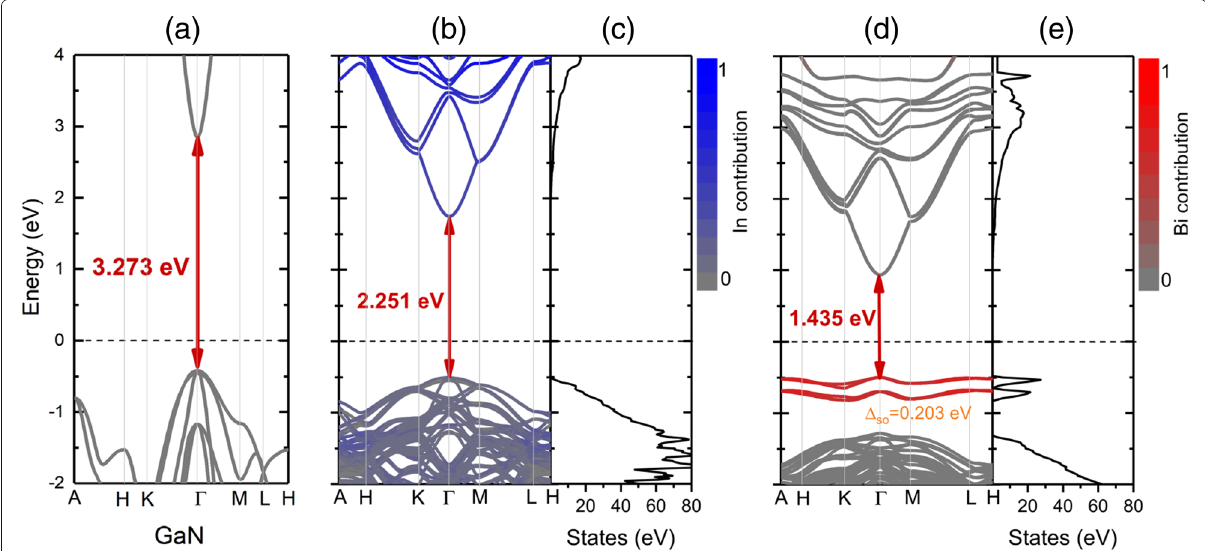
Fig. 5 The projected band structures and their corresponding total density of states (TDOS) of a GaN, b , c In 0.25 GaN , and d , e In 0.25 GaNBi 0.03125 . The black dashed line represents the Fermi level, which sets to be zero. The relative contributions of In and Bi are highlighted by color: blue (red) corresponds to the state originating from In (Bi)